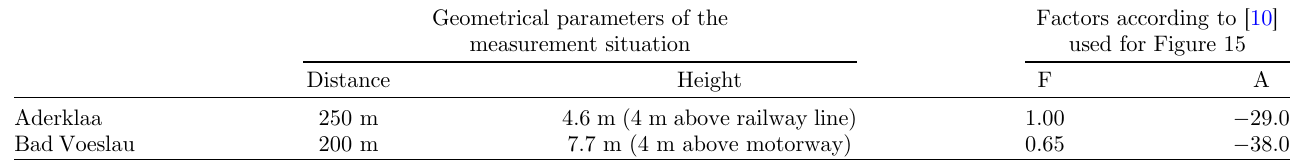
Table 2. The maximum acoustic effects because of meteoro- (cid:6) 0 and c 0 (cid:7) 0 are described in logical in fl uence for c 0 eff eff Salomons and Bakri [10] and agree approximately with our measurement results.